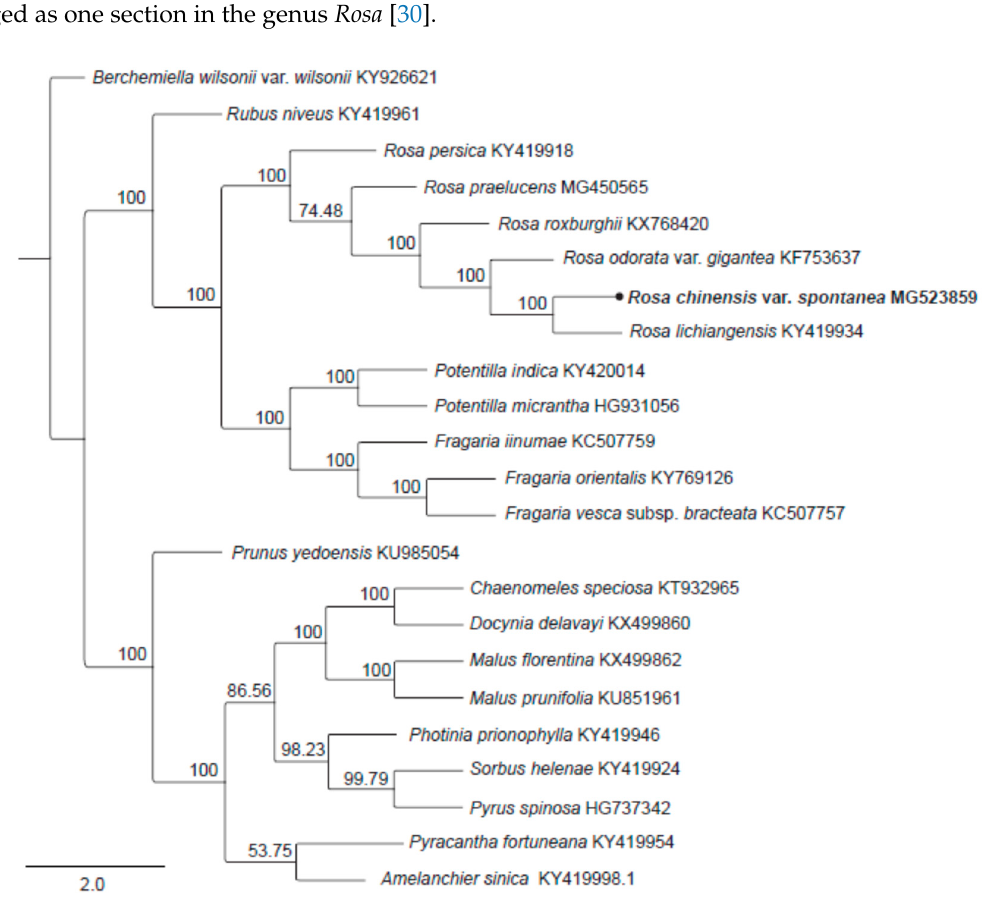
Figure 4. Phylogeny of 22 species within Rosaceae based on the ML analysis of the chloroplast genome’s LSC, SSC, and one-IR regions with Berchemiella wilsonii (Rhamnaceae) as the outgroup. The position of R. chinensis var. spontanea is shown in block letters.